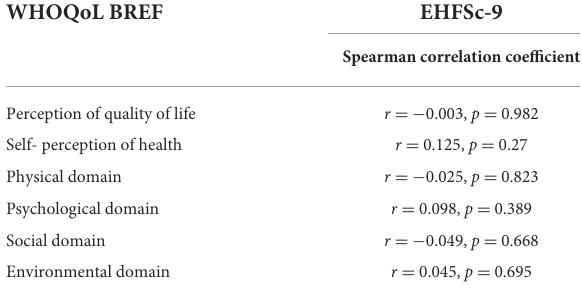
TABLE 4 Perception of quality of life according to WHOQoL BREF questionnaire and perception of own health according to WHOQoL BREF questionnaire in the study group ( N = 80).